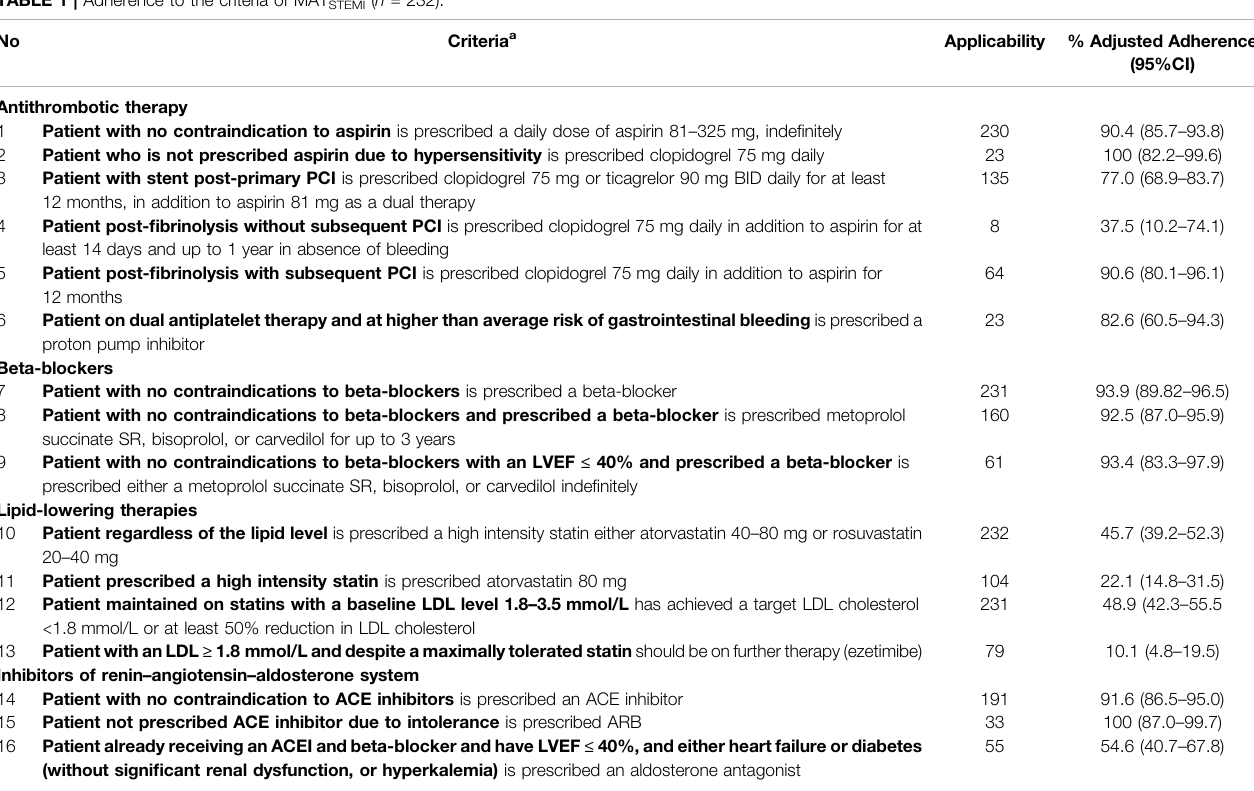
TABLE 1 | Adherence to the criteria of MAT STEMI ( n (cid:1) 232).